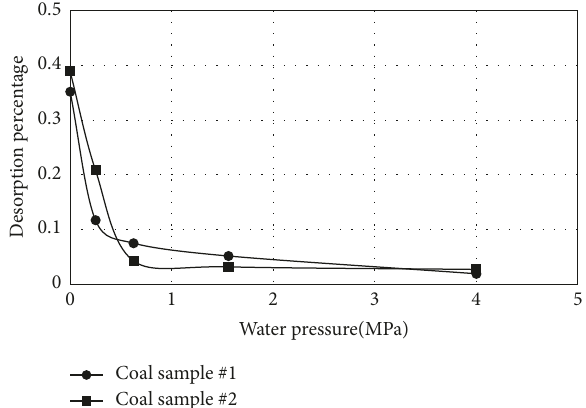
Figure 6: Desorption capacity as a function of water pressure for the two coal samples at 0.50MPa gas adsorption